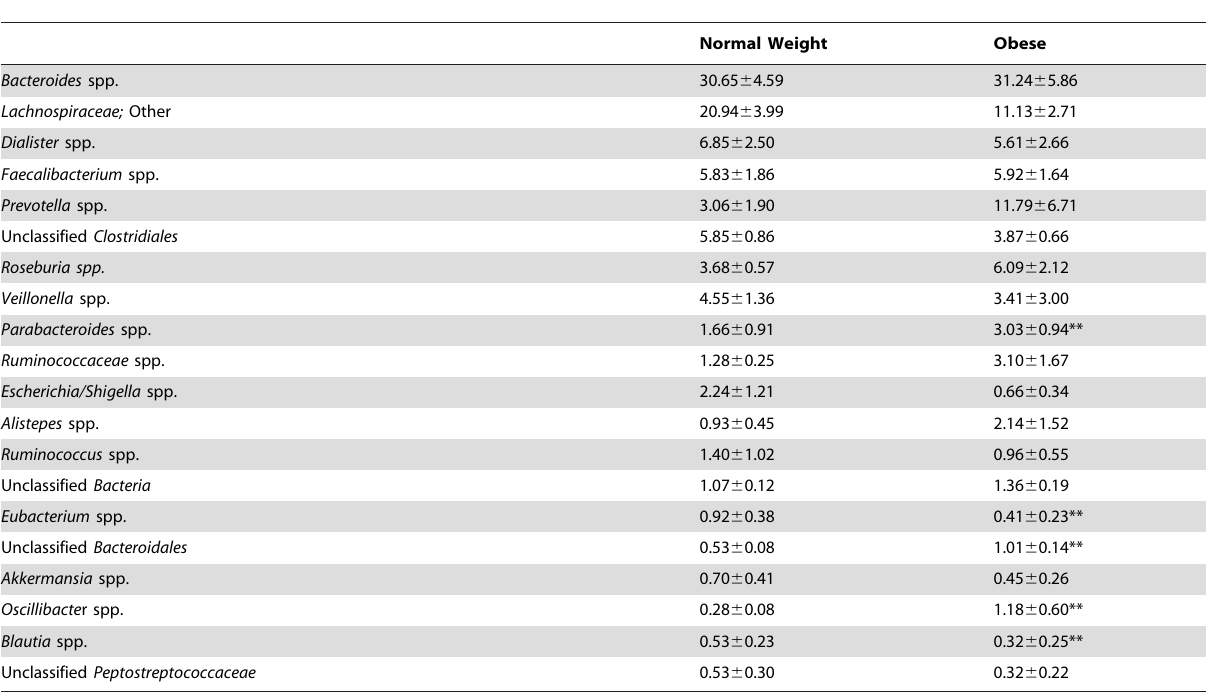
Table 4. Top 20 Most Abundant Genera Among High-Income Subjects.